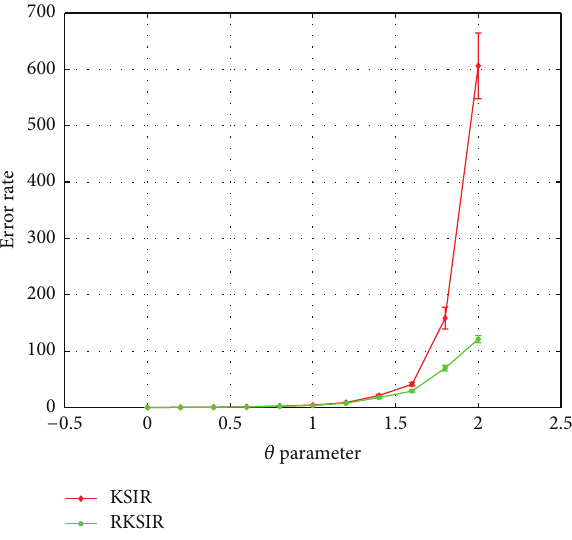
Figure 2: Error in e.d.r. as a function of 𝜃